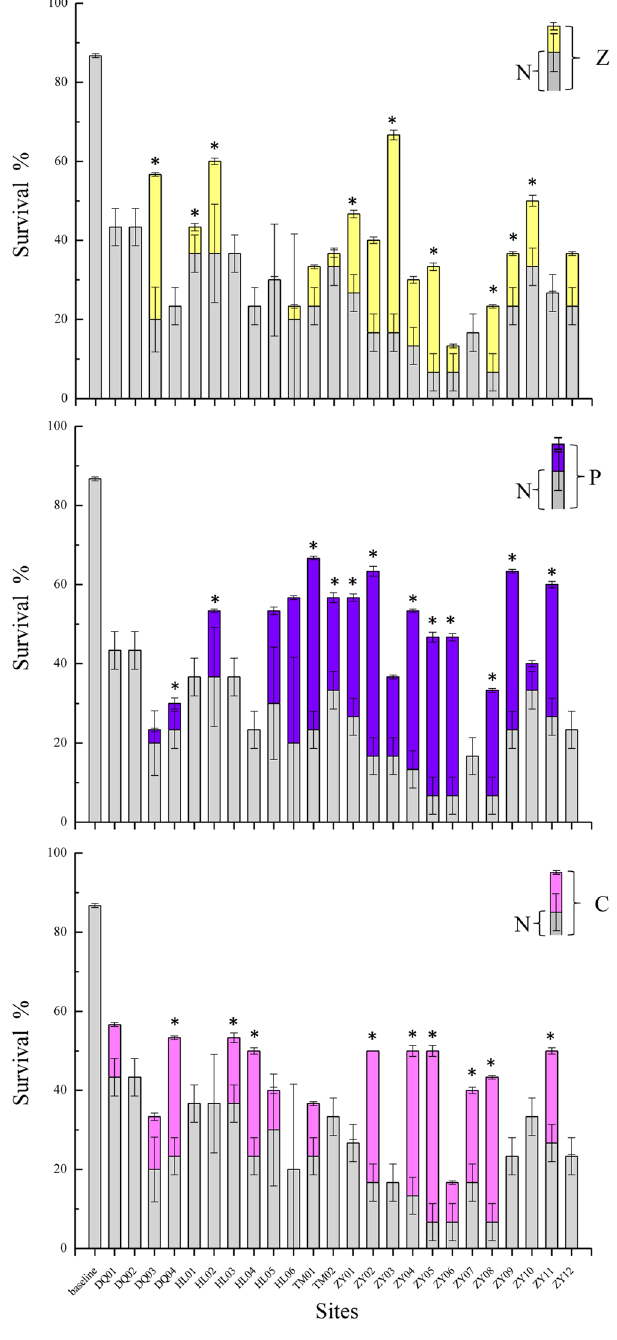
Figure 2. Survival rates of C. dilutus in TIEs Phase I. (N = no addition, Z = add zeolite, P = add powdered coconut charcoal, C = add cation-exchange resin. Stars indicate significant differences (p < 0.05) between the site sediment and the